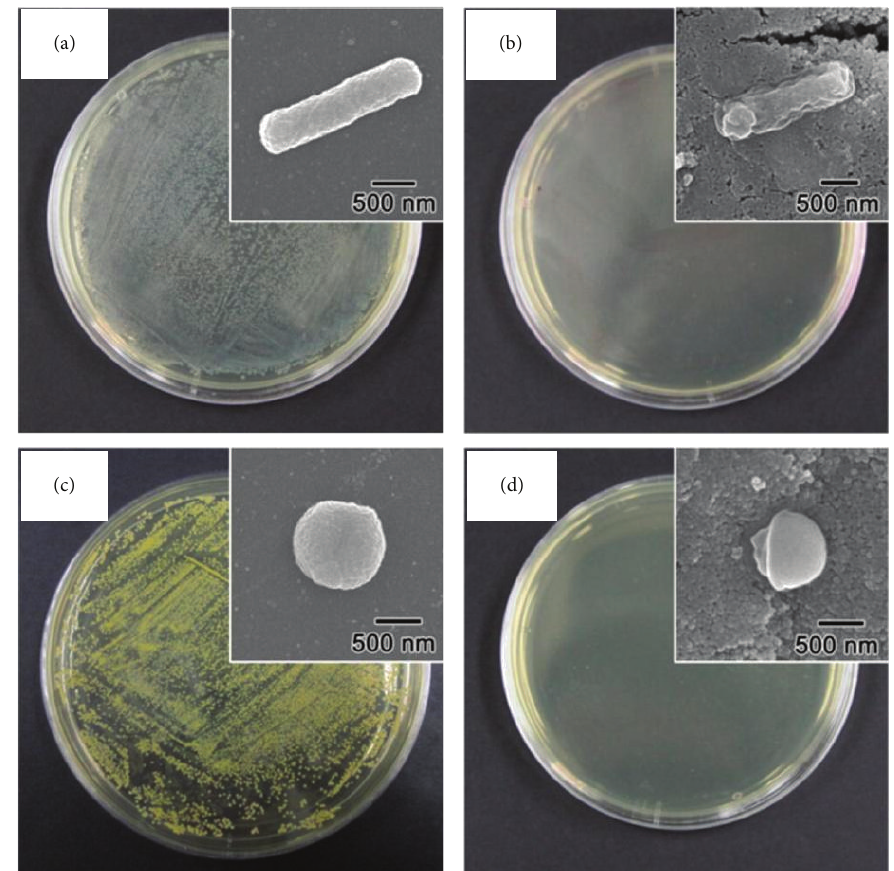
Figure 5: Photographs of colonies of (top) E. coli and (bottom) S. aureus (a, c) without nanoparticles treatment and (b, d) treated with SiO 2 -Ag/PRh nanoparticles. Inset figures show the FE-SEM images of a single bacterial cell (left) in the absence of bactericidal agents and (right) treated with the as-prepared nanoparticles. Reproduce from Song et al. with permission from ACS publishers